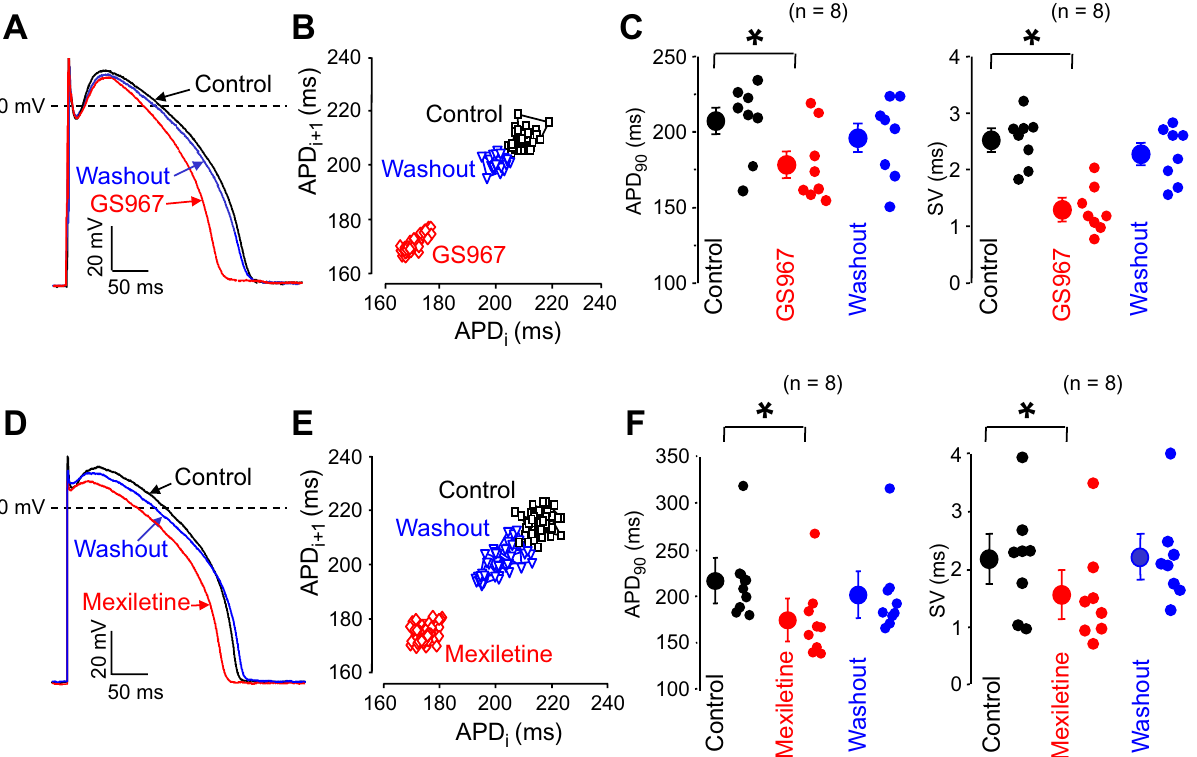
Figure 6. Reversible effects of GS967 ( A – C ) and mexiletine ( D – F ) on beat-to-beat variability of APD in isolated myocytes. Superimposed sets of action potentials ( A , D ) and Poincaré plots ( B , E ) obtained in control, following exposure to 1 µM GS967 or 40 µM mexiletine, and after washout of drugs. ( C ) and ( F ) show the average effects on beat-to-beat variability (SV) and APD. Symbols and bars are mean ± SEM, small dots represent individual data, numbers in parentheses indicate the number of myocytes studied, asterisks denote significant differences between data of the pre-drug control and the GS967- or mexiletine-treated